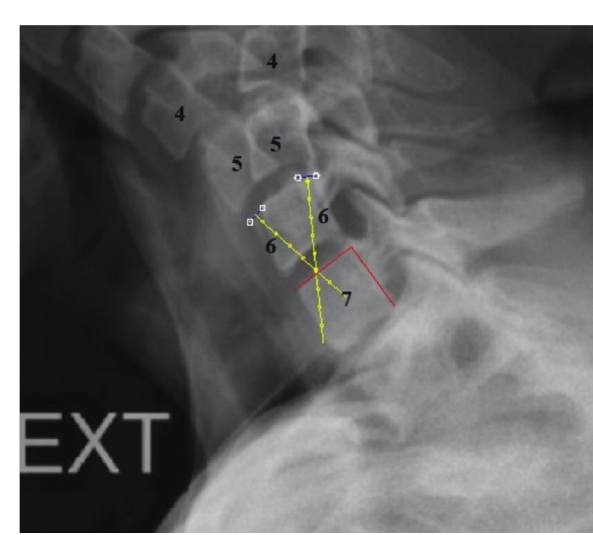
Fig. 1: The overlap of C7 vertebra at cervical flexion and extension images for C6-C7 segment.